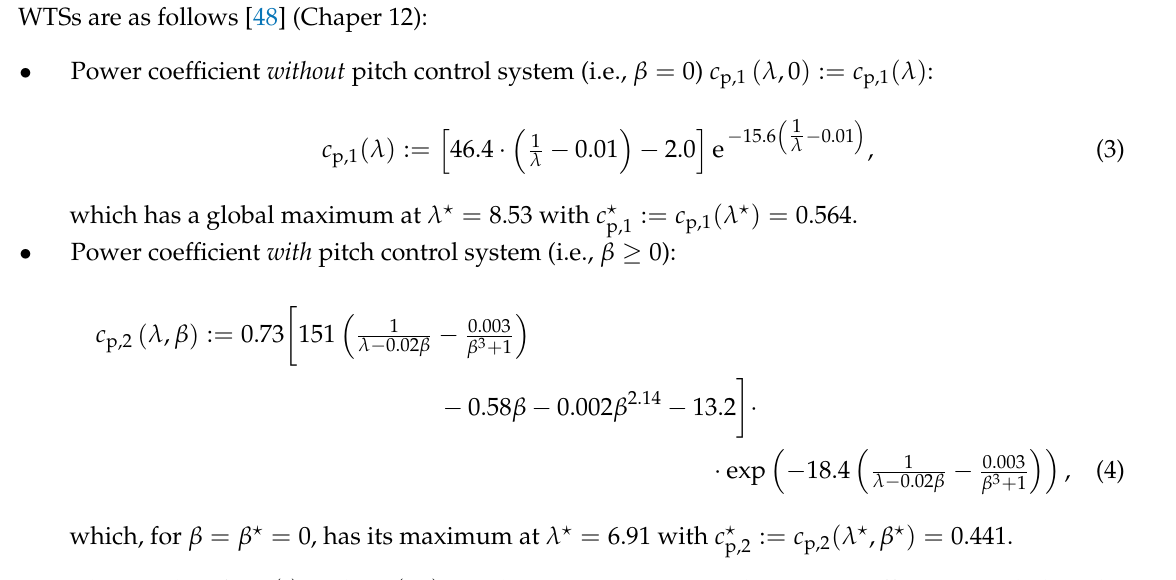
Figure 3. Graphs of the power coefficient approximations c p,1 (